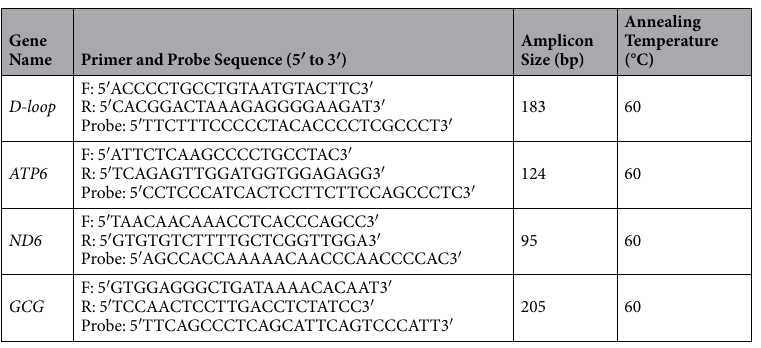
Table 2. The primers and probes used for